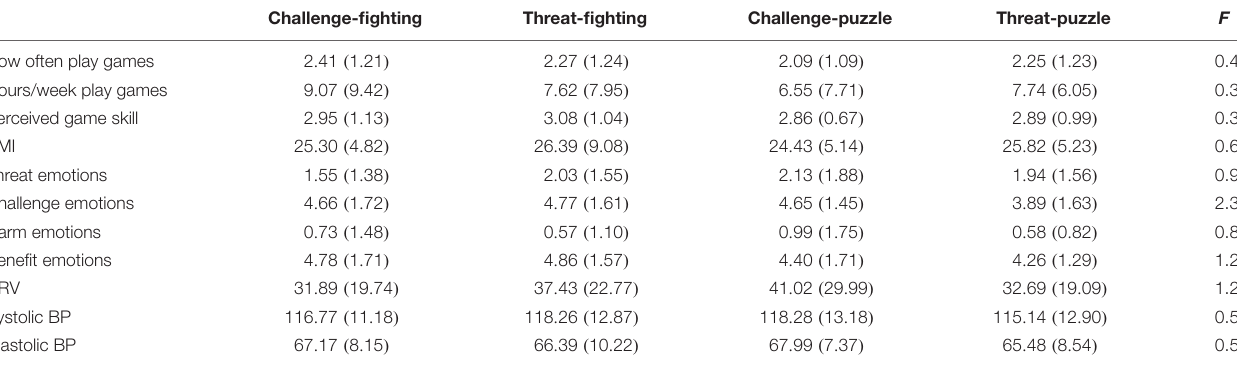
TABLE 1 | Means (SD) for group comparisons across video game experience, health indicators, and baseline cardiovascular and emotion measures.